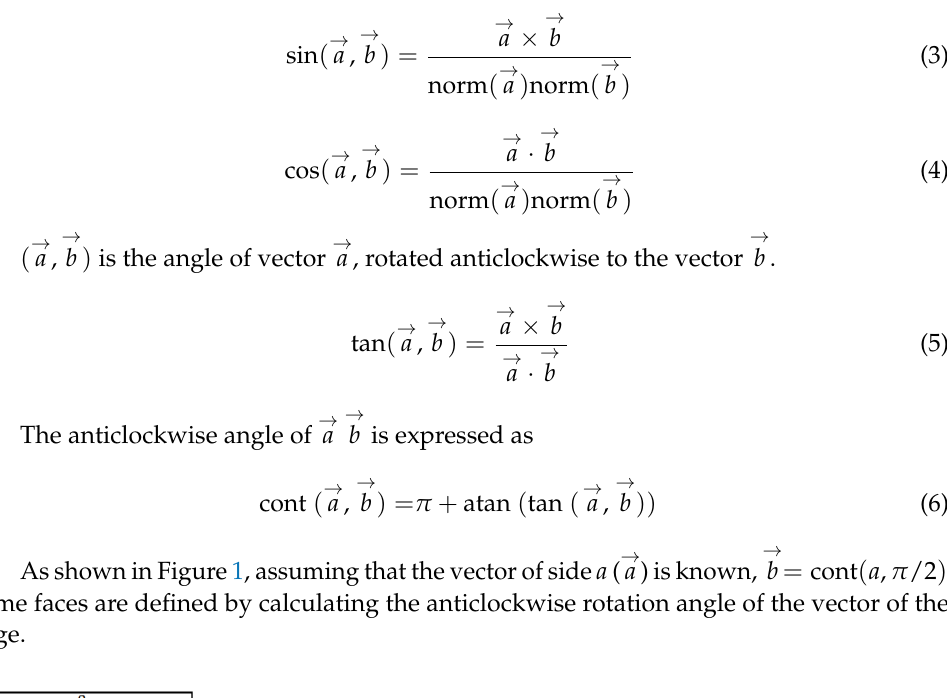
Figure 2. Selecting specific faces. 3.4. Feature Recognition of T-Groove 3.4.1. Selecting Definition Datum Figure 3 shows a typical part manufacturing feature: a T-Groove. The P11 face is se- lected as the definition datum, and the clue indicates the following condition: the face has three convex edges, and one trim. Figure 3. T-Groove( P1-P13 are the correlation surfaces of the features). 3.4.2. Syntactic definition of T-Groove feature The T-Groove feature faces include P2 – P9 and P11. The defining order of the faces is P11 → P9 → P8 → P7 → P6 → P5 → P4 → P3 → P2. The T-Groove syntax pattern is defined as fol- lows: Joint-Edge (Joint-Edge (Joint-Edge (Joint-Edge (Joint-Edge (Joint-Edge (Joint-Edge (Joint-Edge (Joint- Edge (P11, P9,1.5π)P9 ( π ) , P8,0.5π)P8 ( π ) ,P7, π)P7 ( π ) , P6,π)P6 ( π ), P5,π)P5 ( π ), P4,π)P4 ( π ), P3,0.5π)P3 ( π ) , P2,1.5π)P2 ( π ) ∩Parallel(P11,P8) ∩Parallel(P11,P4) ∩Parallel(P11,P2) ∩Parallel(P9,P3) ∩Coplanar(P7,P5).